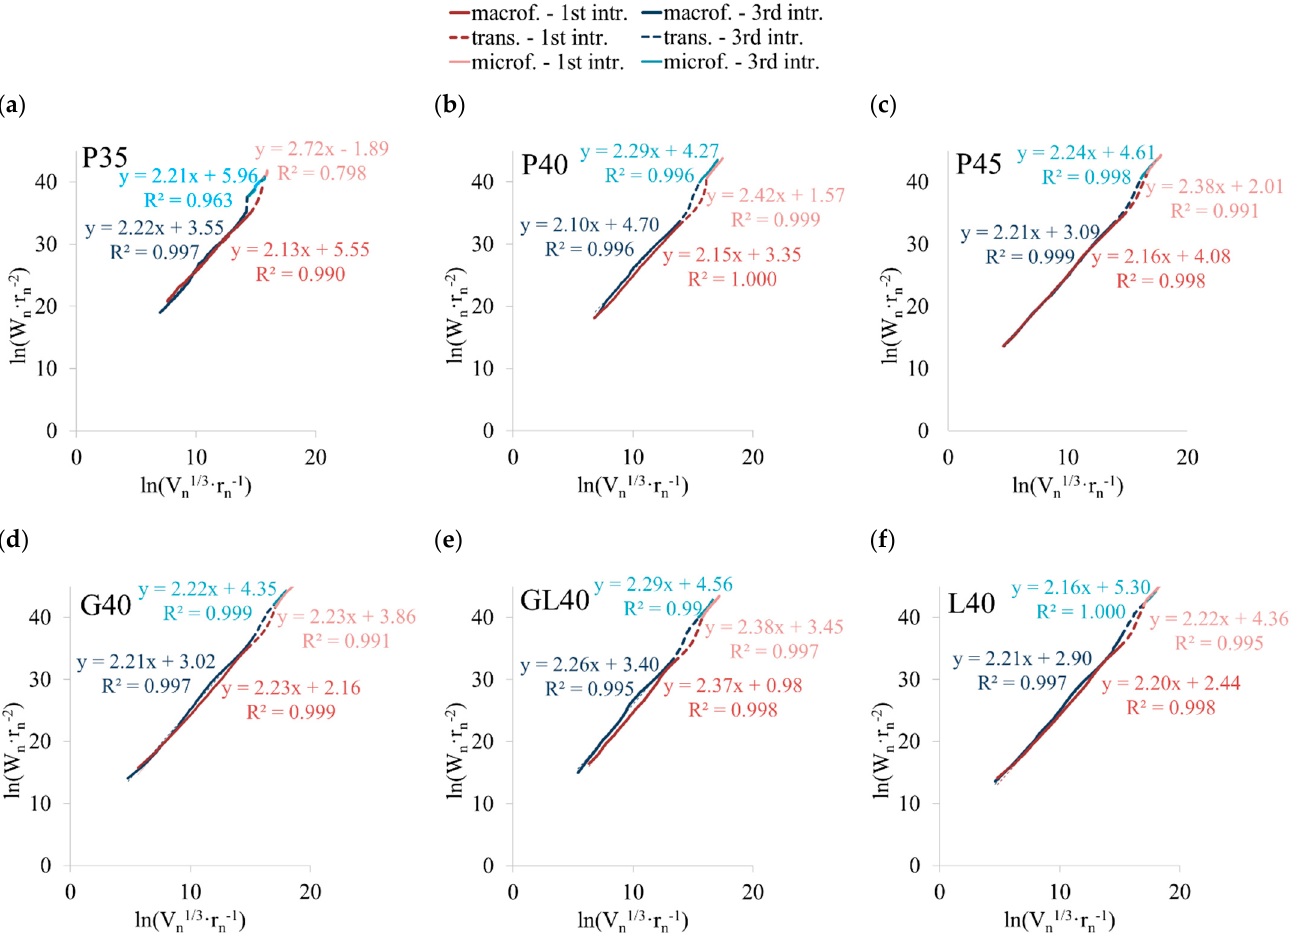
Figure 4. Surface fractal dimension values for first and third MIP cycles for mixes. ( a ) P35, ( b ) P40, ( c ) P45, ( d ) G40, ( e ) GL40 and ( f ) L40.